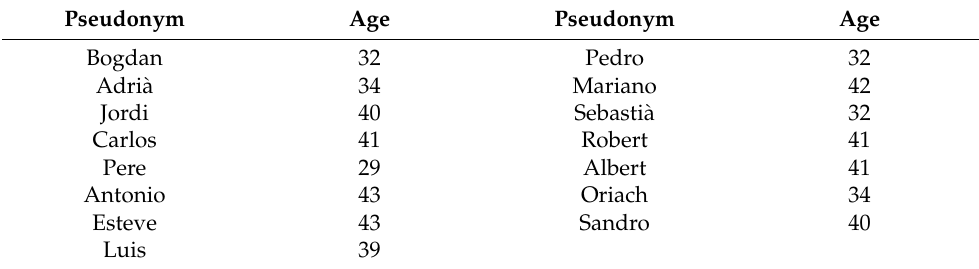
Table 1. Interviewees’